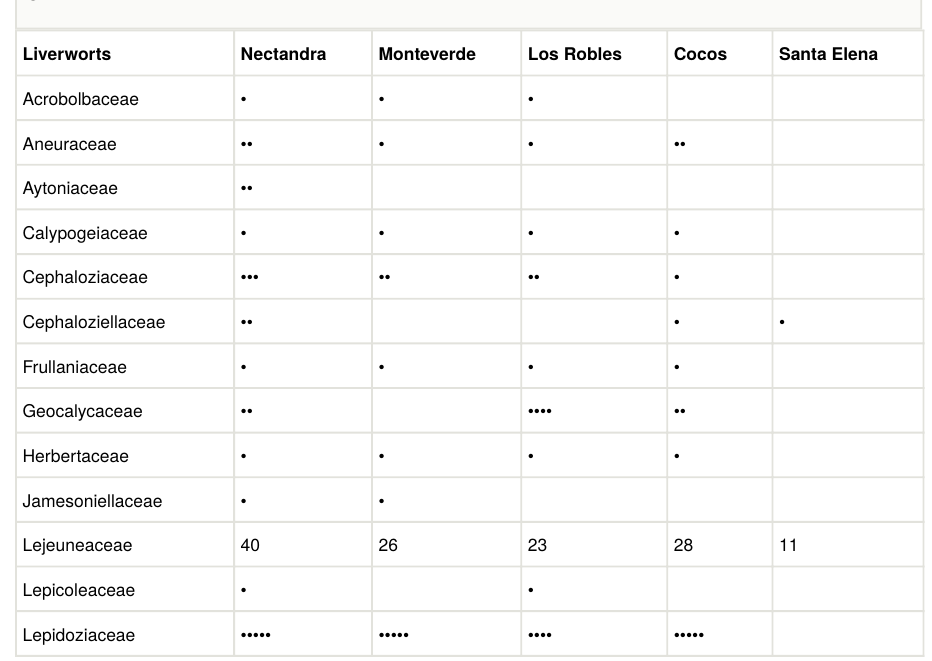
Table 4. Number of liverwort genera by family of the fi ve sites. Each dot (•) = one shared genus; Each (o) = genus not at